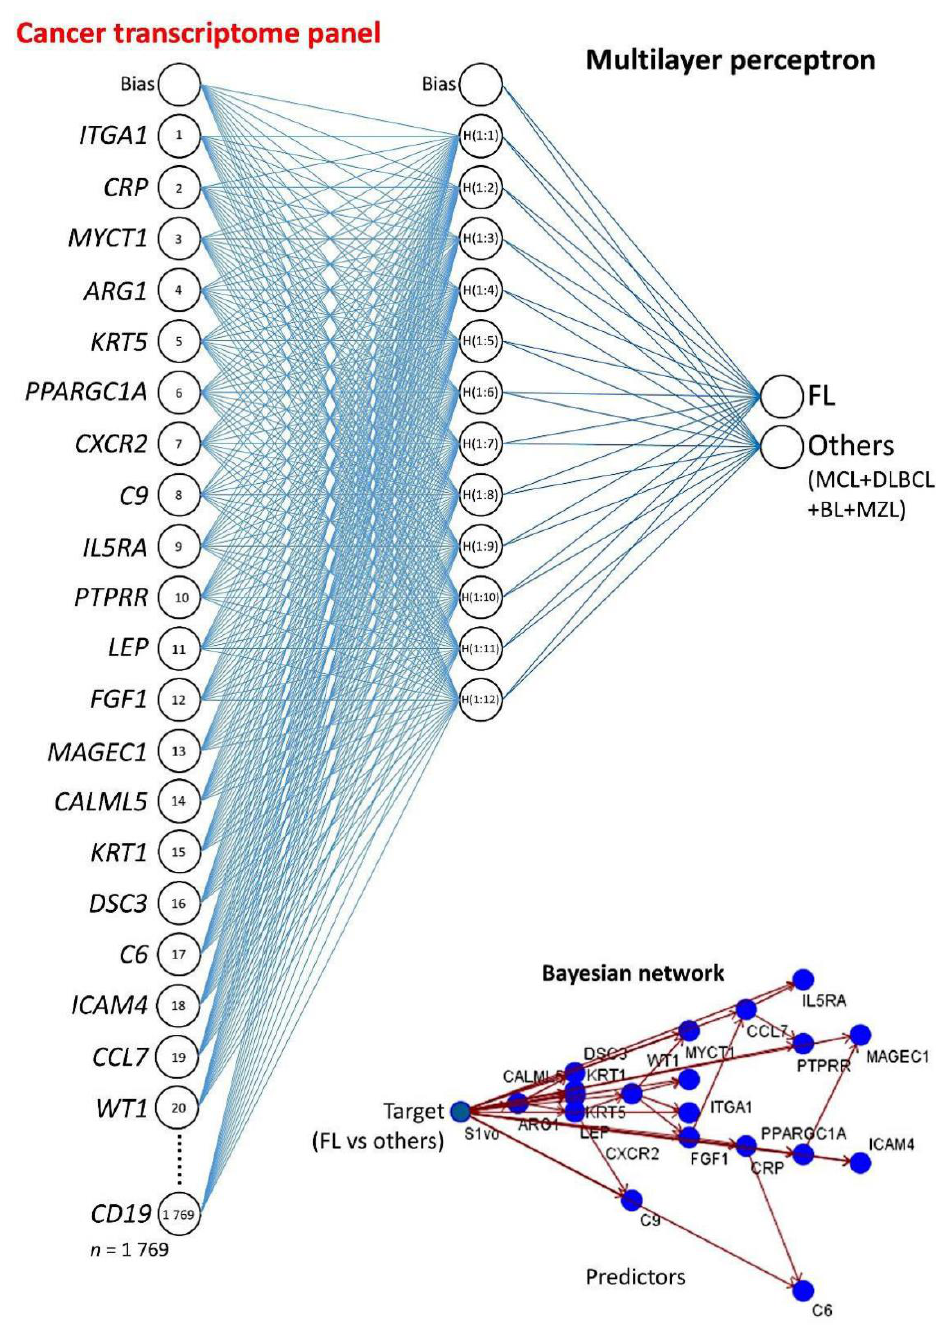
Figure 7. Network diagram of the MLP for predicting FL vs. the other NHL subtypes, based on a cancer transcriptome panel ( n = 1769). This figure shows the architecture of the neural network used to input the gene expression of the cancer transcriptome panel and to output the FL vs. other NHL subtypes (MCL + DLBCL + BL + MZL). The top 20 genes are shown in order of importance according to their normalized importance for prediction. Interestingly, CD19 was the least important gene, which makes pathological sense as CD19 is a pan B-cell marker. A Bayesian network analysis for predicting FL vs. others by the top 20 genes is shown at the bottom of the figure.